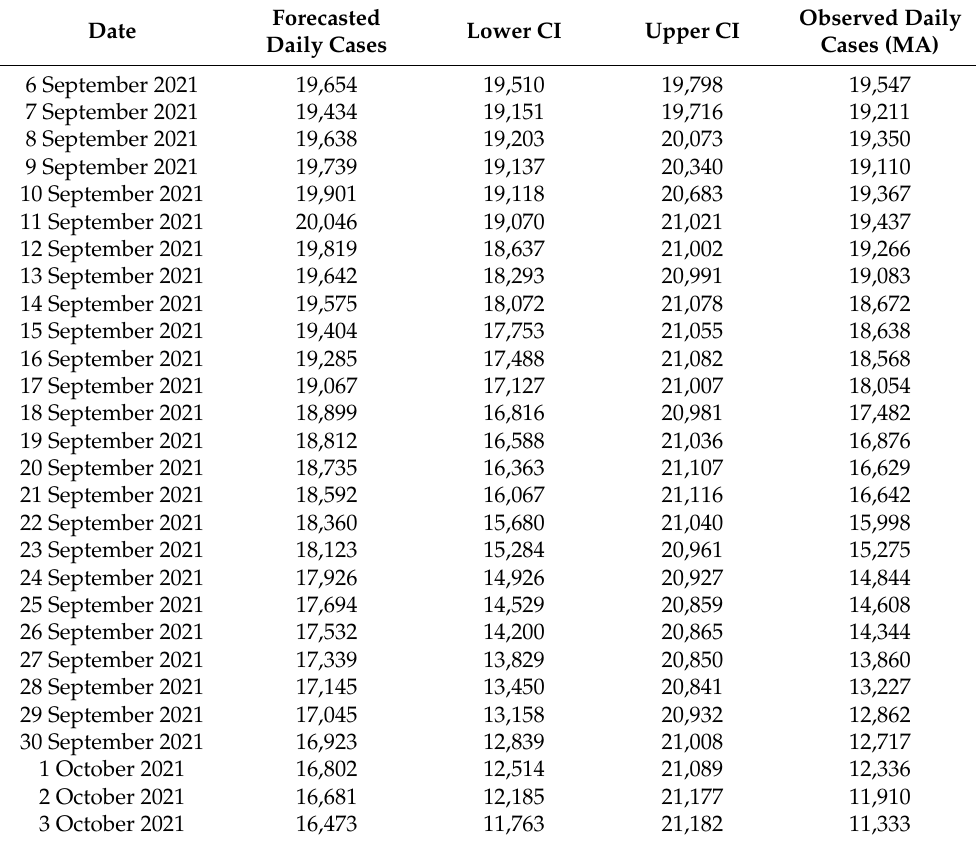
Figure A2. ACF and PACF plots for the original time-series ARIMA model. Table A1. Forecasted and observed daily COVID-19 cases, Malaysia.